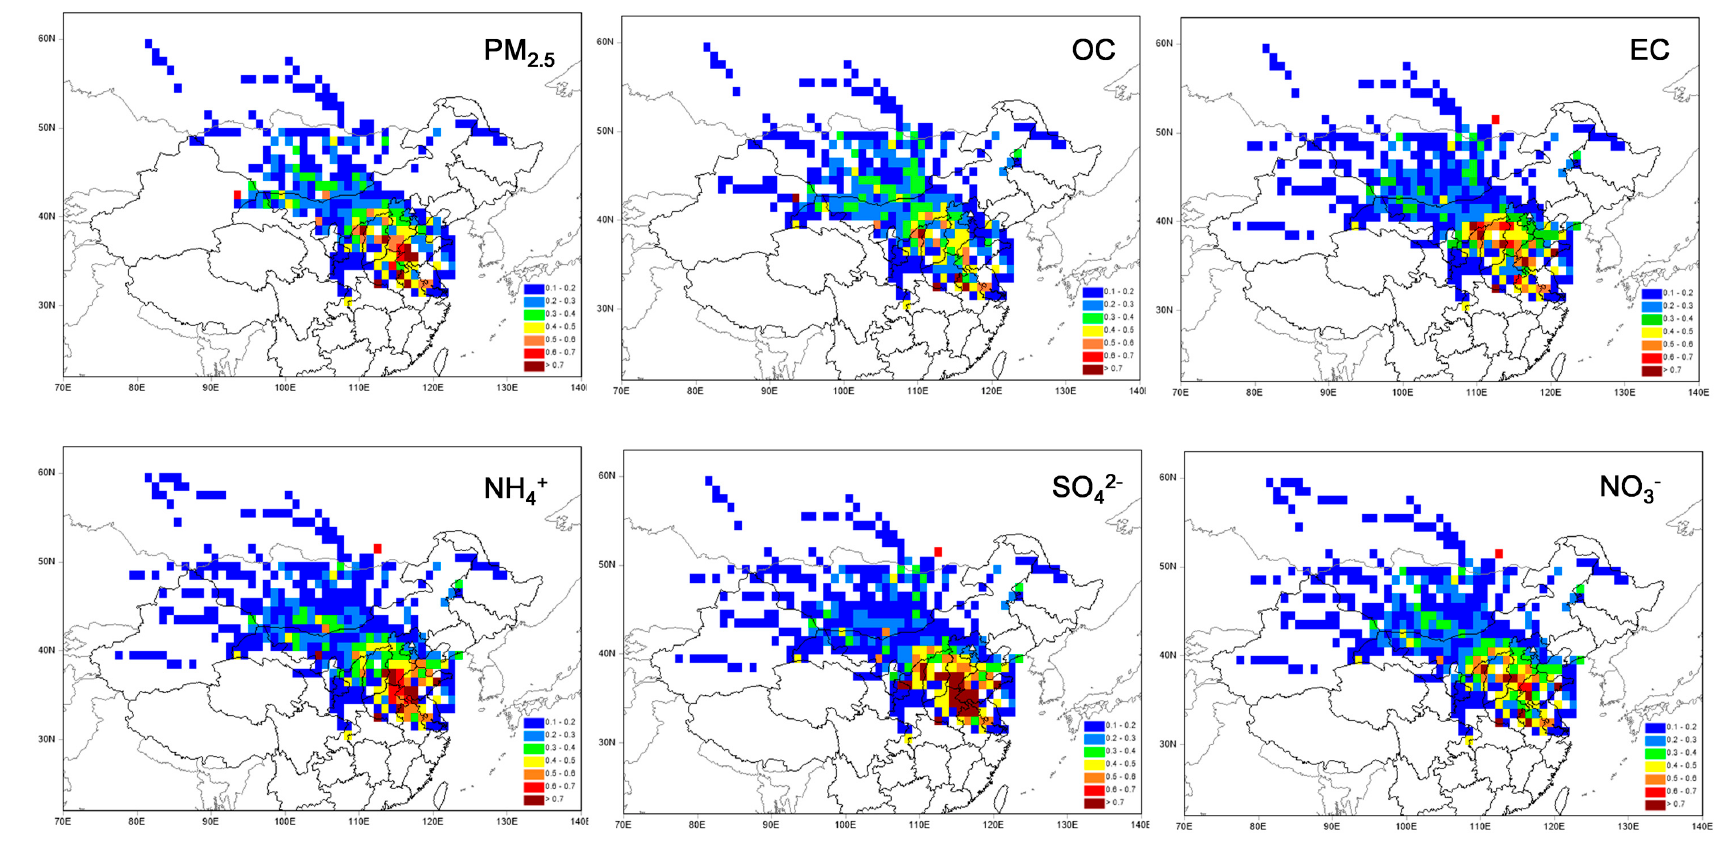
Figure 8. The potential source contribution function (PSCF) values for PM 2.5 , SNA (sulfate, nitrate, and ammonium), and carbonaceous aerosols at SDZ station.